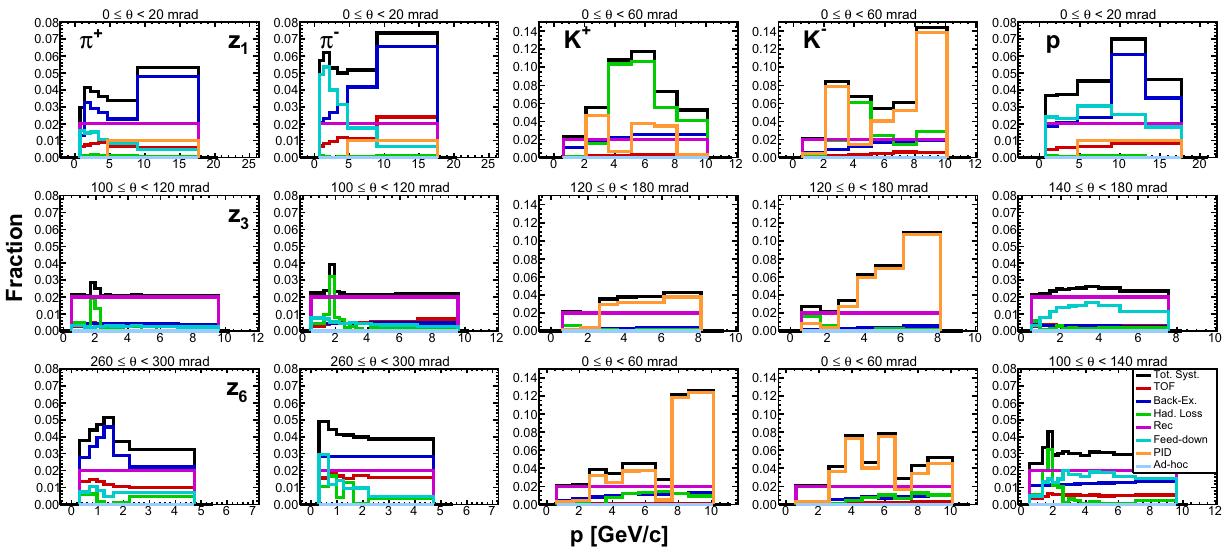
Fig. 22 Systematic uncertainties for the measured yields as a function of momentum. Each column corresponds to a different particle type, from left to right: π + , π − , K + , K − , and p. Each row corresponds to